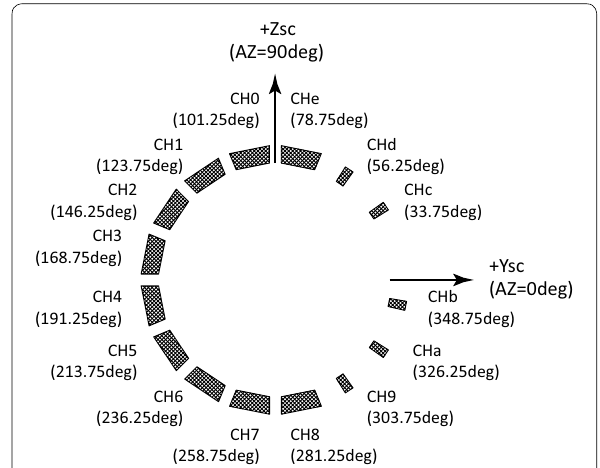
Fig. 2 Channel definition of LEPi. LEPi has a planar FOV in the Y sc Z sc plane. Illustrated direction corresponds to the velocity direction of the incoming particles. Channels 0–8, and e are wide channels, while channels 9–d are narrow channels. The positions of the center of the anodes in the satellite frame of reference are shown in parentheses